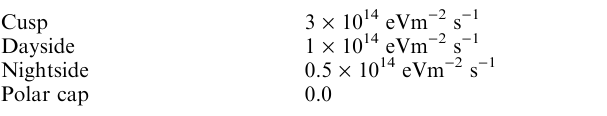
Table 1. Values for the downward magnetospheric electron heat